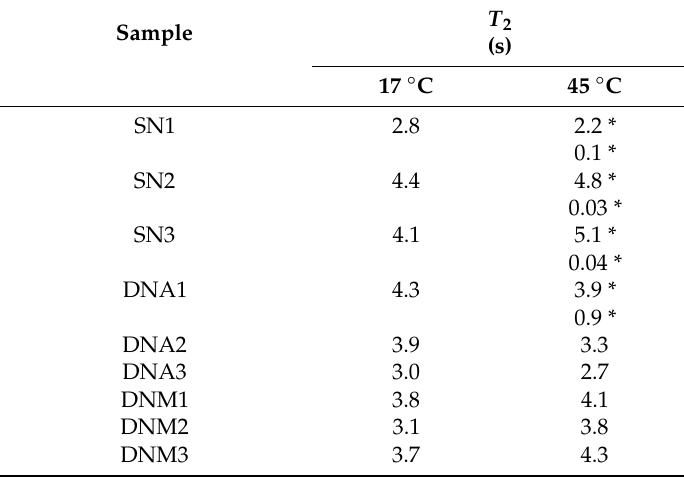
Table 5. Spin-spin relaxation times T 2 of hydrogen-deuterium oxide (HDO) protons for SN and DN hydrogels measured at 17 ◦ C and 45 ◦